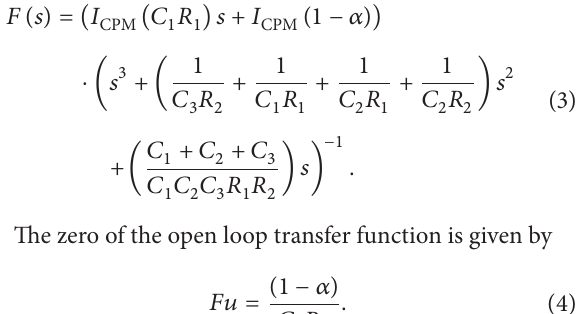
Figure 4: Block diagram of the proposed dual-CP SSCG with fast- settling CP control